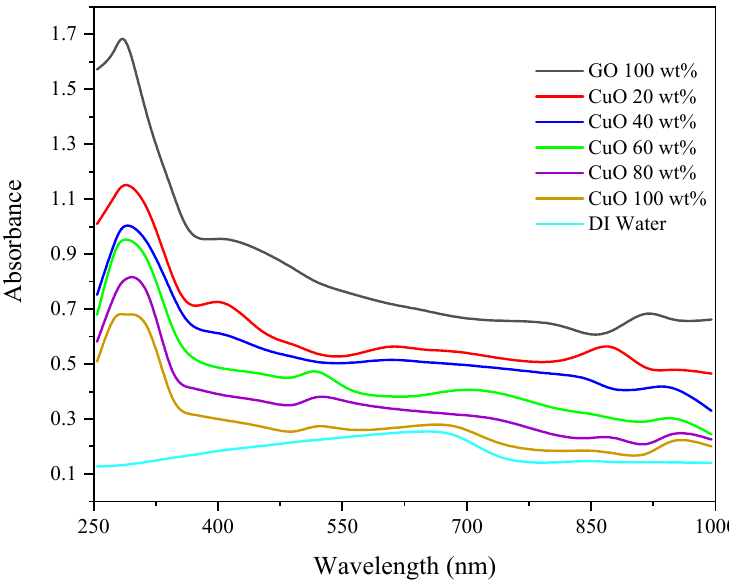
Figure 3. UV absorption spectra of GO–CuO binary nanocomposites at 0.0004 wt % concentration.